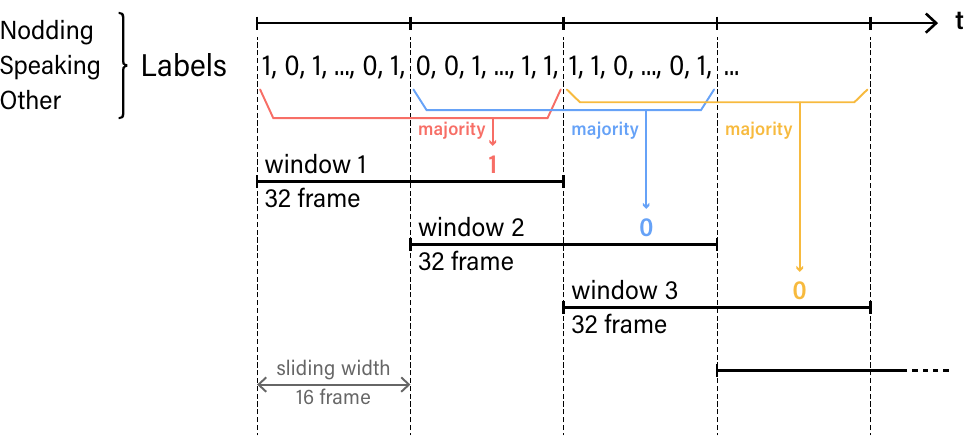
Figure 6. Sliding window algorithm used for feature extraction. In each time frame, there is a label of micro-behaviours. Label is normalized into an integer. One window is 32 frame. Sliding width is 16 frame. The label with the high majority will be a feature for each window. Nodding is the action of a human individual moving its own head in the vertical direction. Hence, we focus on using the rotation feature, pose_Rx component shown in Figure 5. With the pose_Rx , we used the sliding window algorithm to extract features. We set a window frame of 1.06 Section (32 frames) and overlap at 50%. The detailed features extracted are shown in Table 1. Since we only used single features pose_Rx , we removed sma , correlation , and angle . These features are the ones calculated by using multiple features. Speaking is the action of an individuals in moving their upper and lower lips. When a person speaks, the distance between the upper and lower lips becomes larger. In order to collect this feature, we used face point number 62 and 66, shown in Figure 5. The distance between number 62 and 66 is the parameter. Then, we applied the sliding